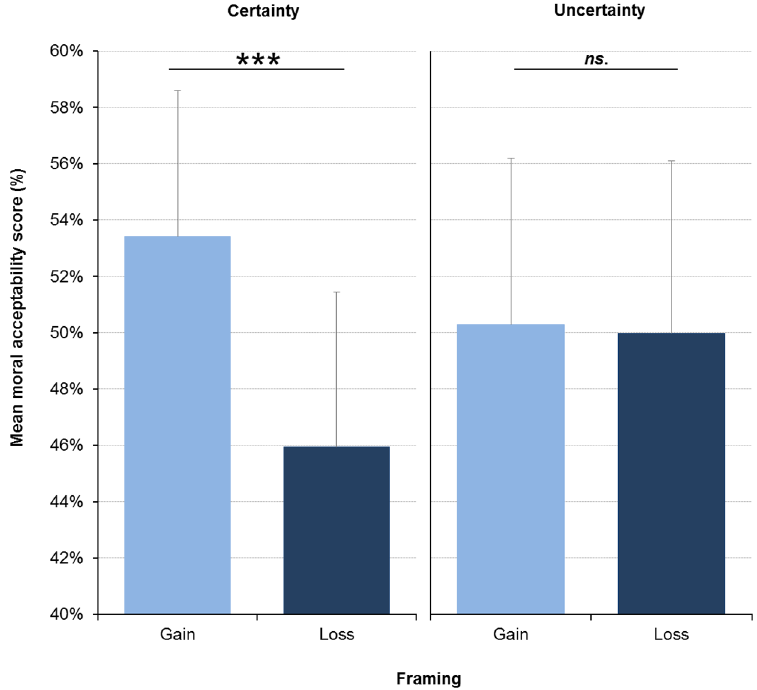
Fig 3. Mean moral acceptability score as a function of framing (gain, loss) and (un)certainty (certainty vs . uncertainty). Bars represent 95% CI.